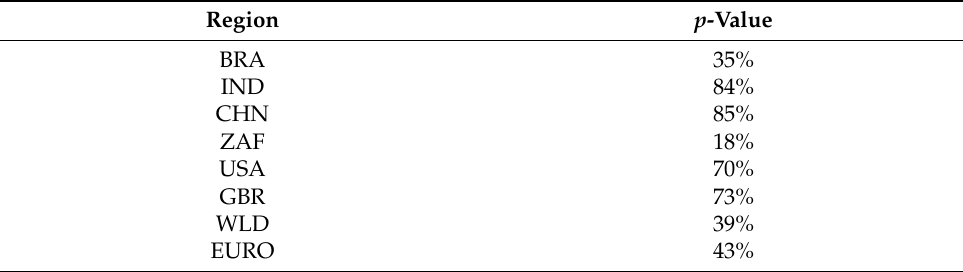
Table 2. The p -value of the Jarque Bera Test for the selected regions. Region p -Value BRA 35%